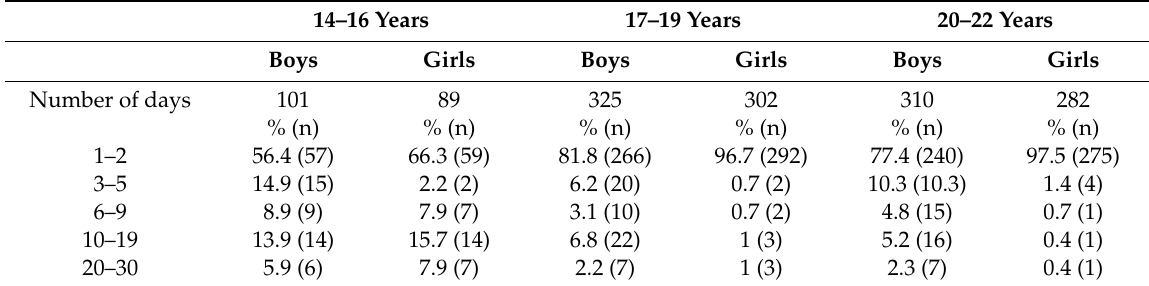
Table 3. Frequency and percentage frequency for the number of days Ellisras Longitudinal Study (ELS) subjects saw community members drinking alcohol next to the school during school hours in the past 30